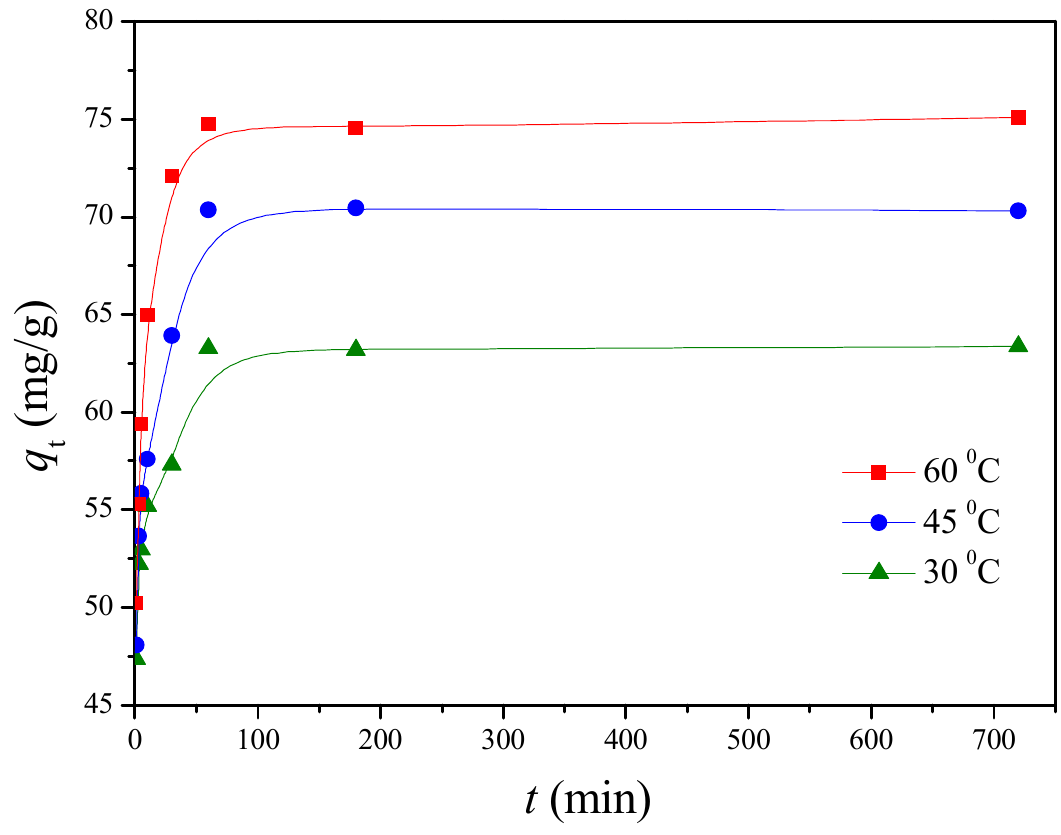
Figure 5. Effect of temperature on the adsorption of Cu(II) onto G1H20 nanoparticles at a pH of 6. The pH of the solution is an important parameter in the removal of heavy metals